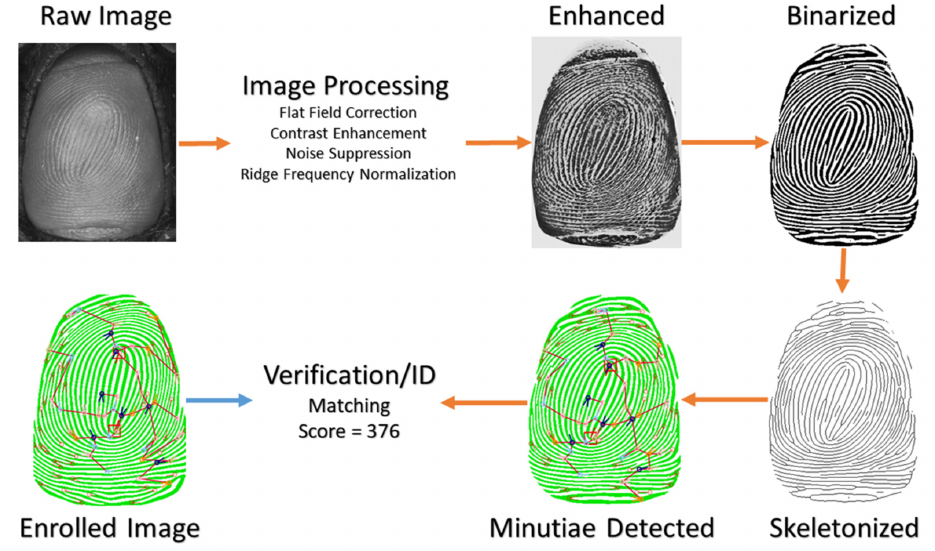
Figure 15. Image processing